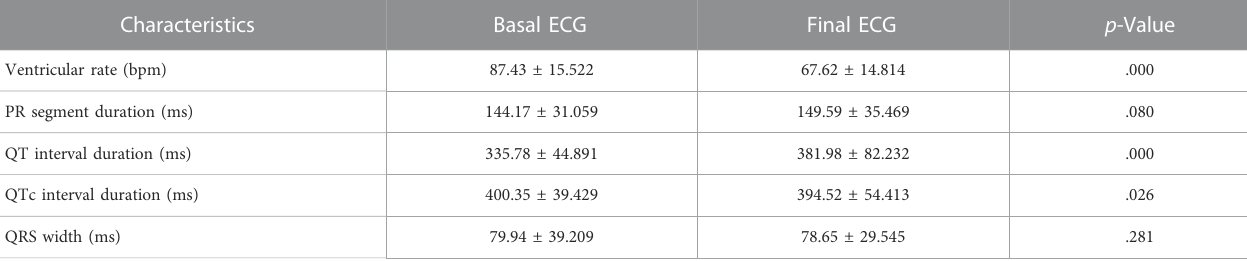
TABLE 5 ECG characteristics before and after Remdesivir